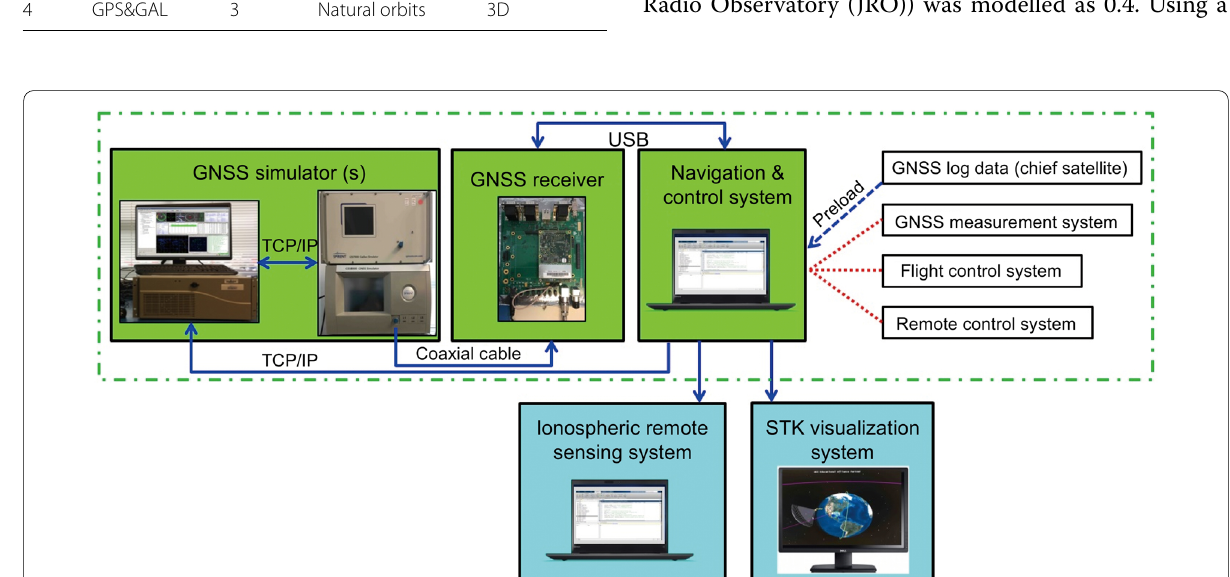
Fig. 11 GPS-based VTFFTB configuration. (Adapted from Peng et al.